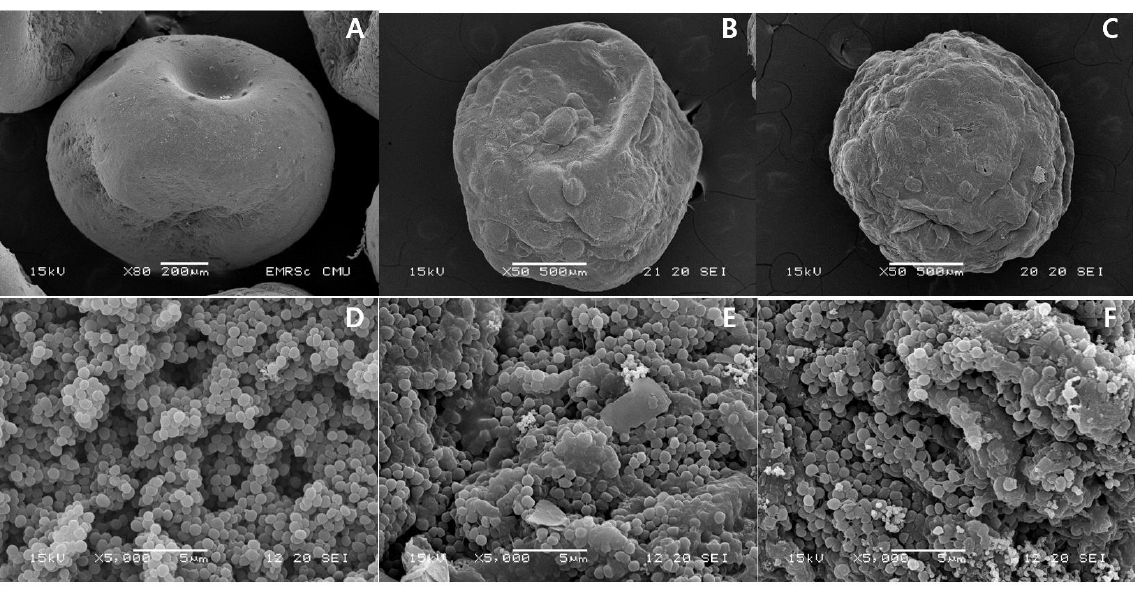
Figure 6. Morphological changes in the microcapsules loaded with B. breve TISTR 2130 without exposure to the simulated gastrointestinal conditions ( A , D ), after exposure to SGJ for 1 h ( B , E ), and after sequential exposure to SGJ for 1 h and SIJ for 4 h at 37 ◦ C under anaerobic conditions ( C , F